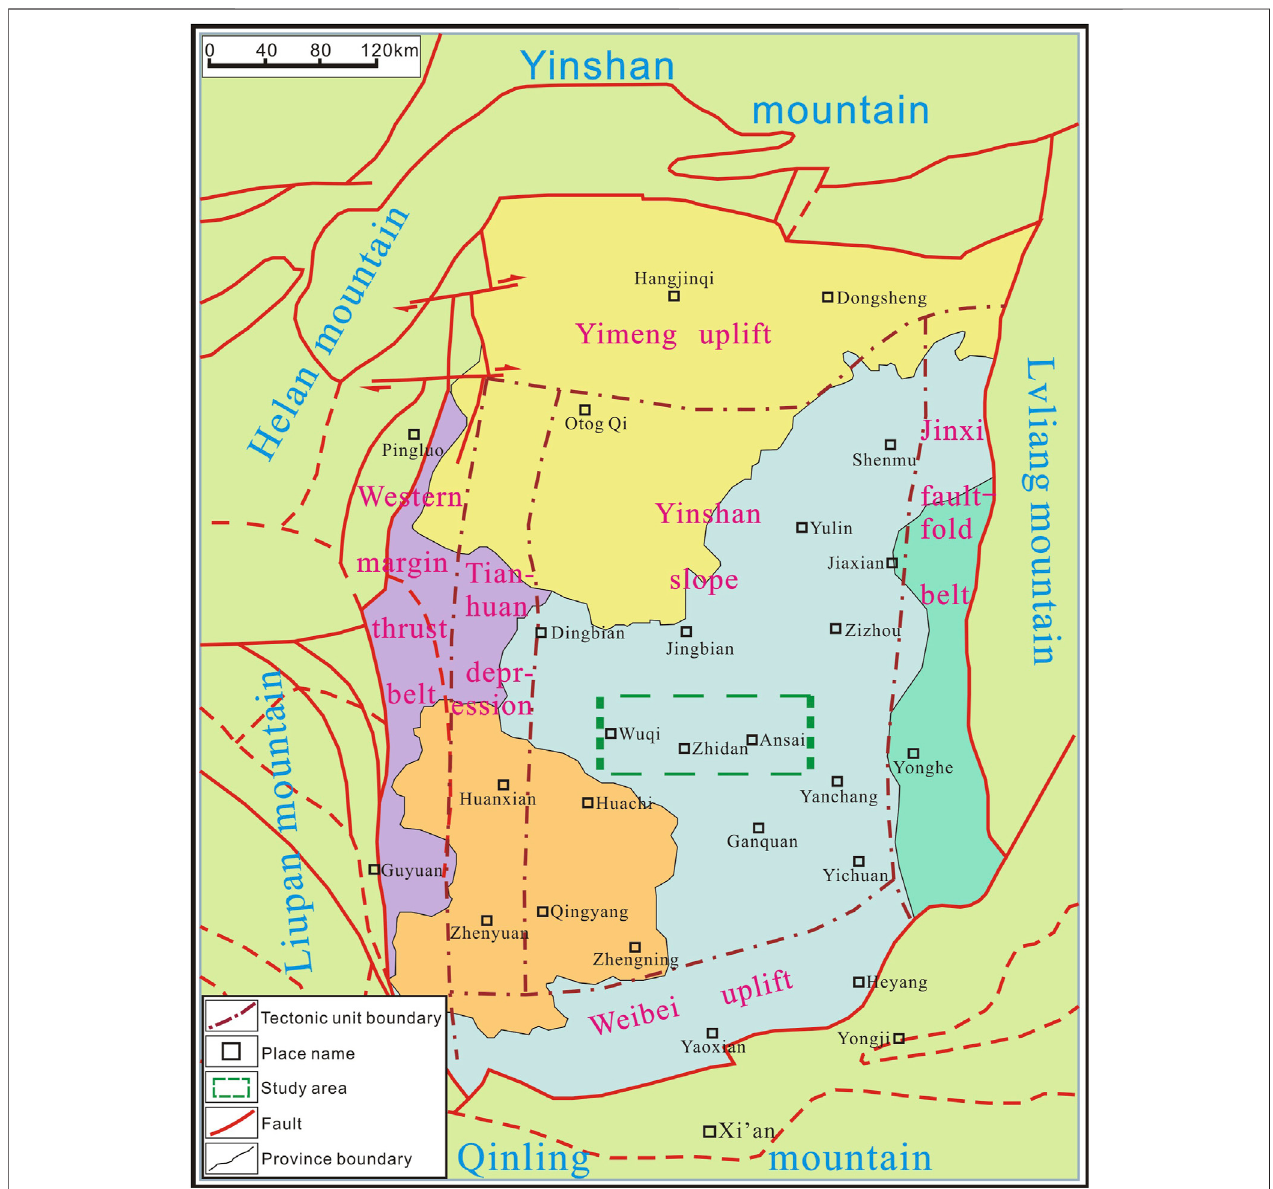
FIGURE 1 | The location map of the studied